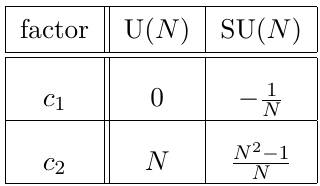
Table 2 . The color factors c 1 and c 2 subject to c 2 − c 1 = N arise in the forward limits of traces over generators of the gauge groups U( N ) and SU( N ) , see